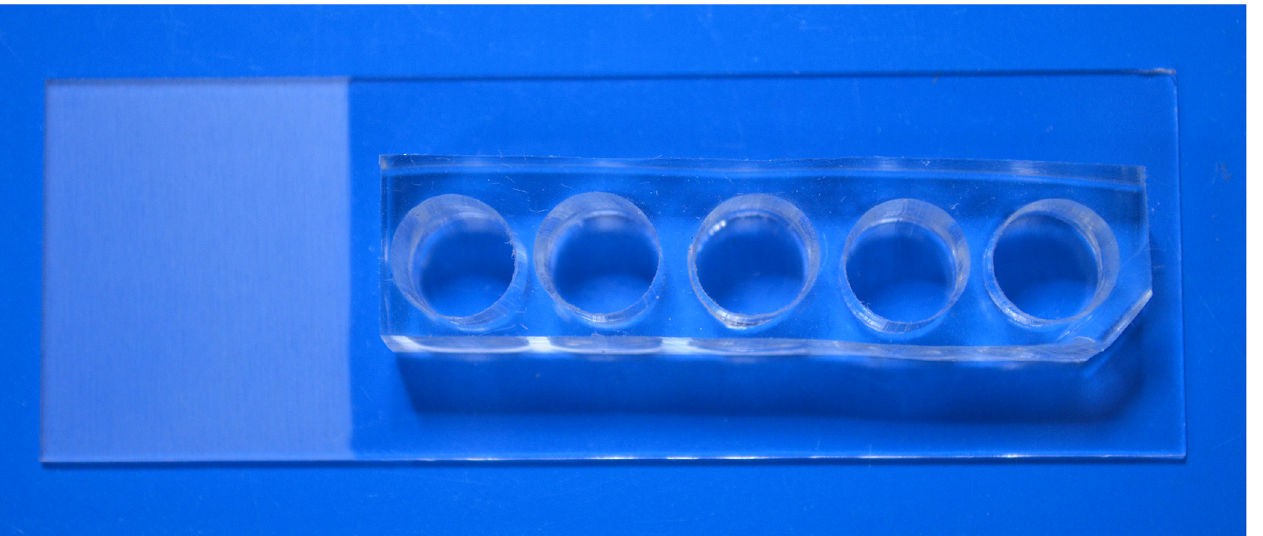
Fig 1. Picture of the homemade PDMS chambers for liposome production. The chamber size is 8 mm in diameter and 10mm in height). PDMS firmly adheres on a glass slide.